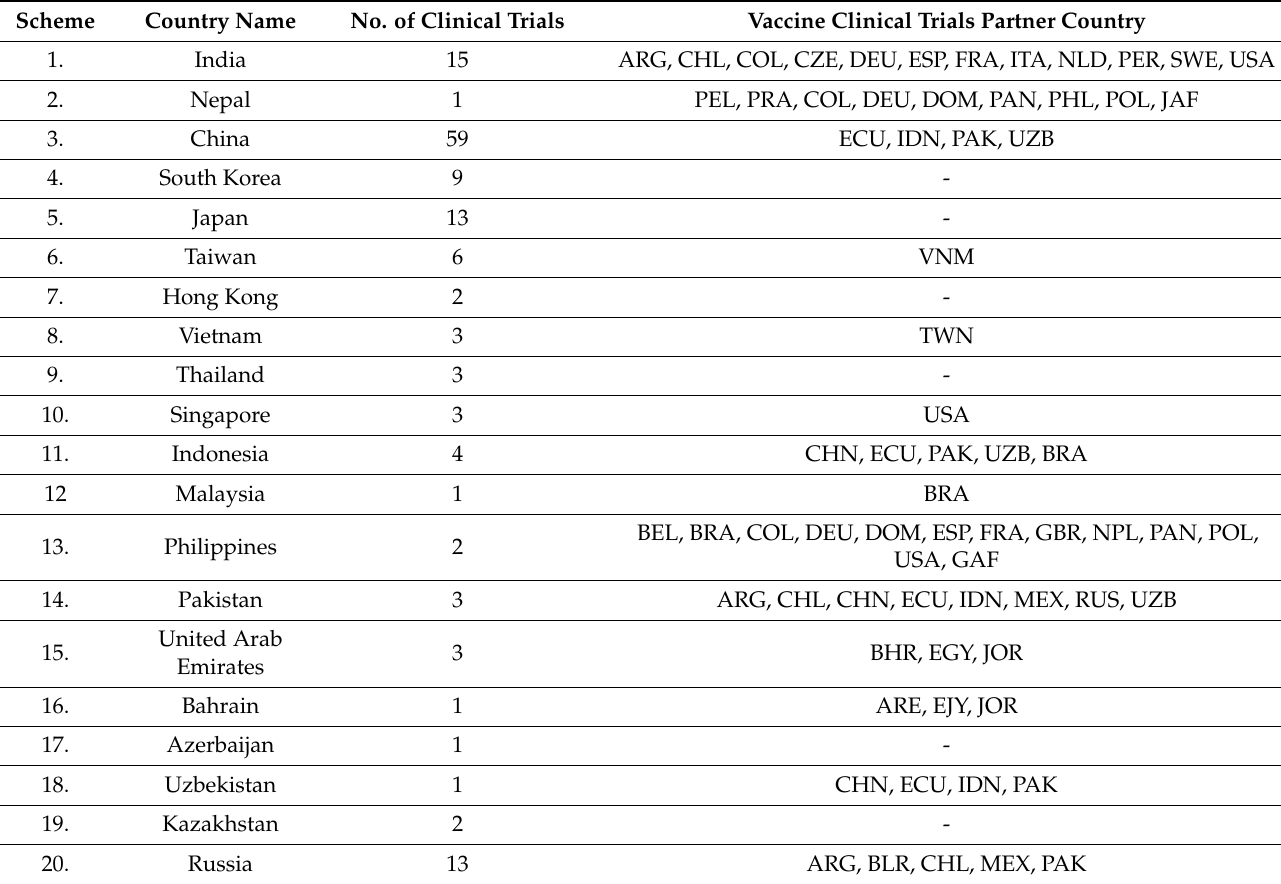
Table 3. Networking to understand the collaboration between the partner country involved in clinical trials or any point of COVID-19 vaccine development.